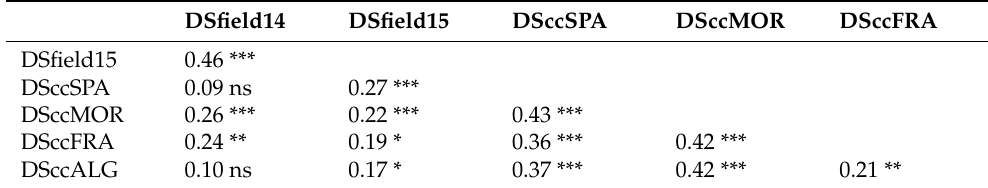
Table 3. Pearson’s linear correlation coefficient between DS accessed under field and controlled conditions trials. ***, **, * = p < 0.001, <0.01, <0.1, respectively; ns = not significant.